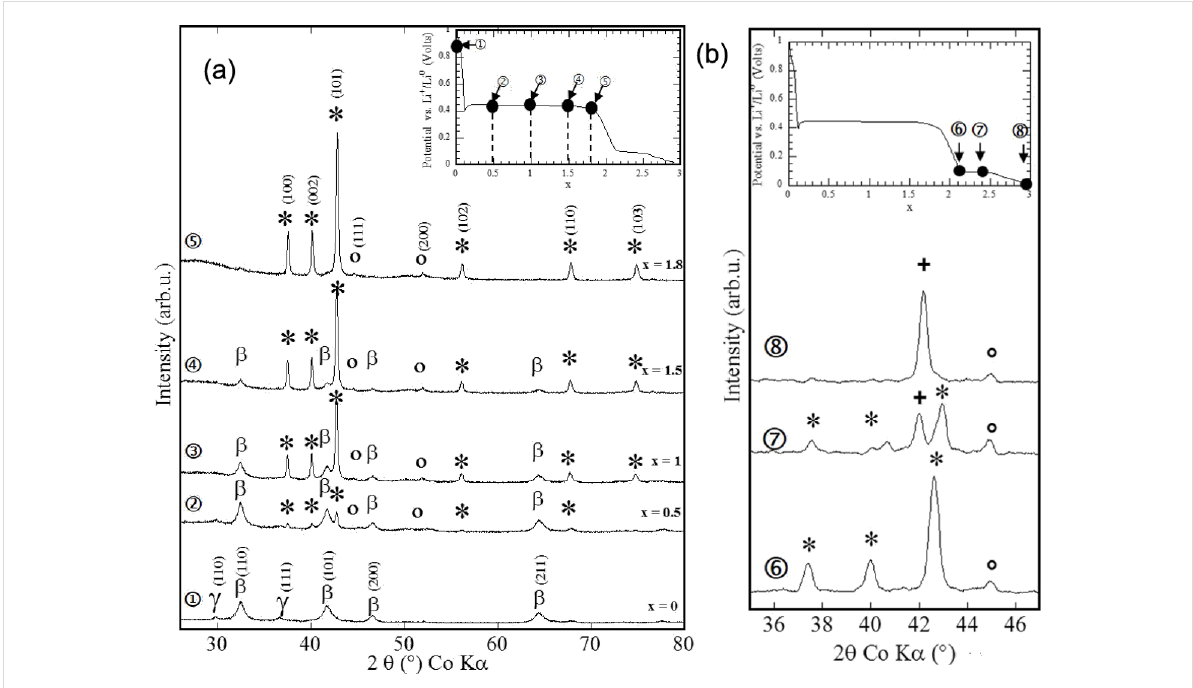
Figure 4: Potential profile and XRD patterns of MgH 2 electrode at different stages of the conversion reaction. (a) Inset: Evolution of the potential (V) as a function of x (mole fraction of Li) for a MgH 2 electrode cycled between 3 and 0.005 V at a rate of one equivalent of lithium in 100 h. The recorded XRD patterns are associated with the various stages of the discharge, denoted by the numbers (1), (2), (3), (4) and (5) in panel and correspond to x = 0 (starting electrode material), x = 0.5, 1, 1.5 and 1.8, respectively. The X-ray peaks marked by an asterisk, β , γ and circle correspond to Mg, β -MgH 2 , γ -MgH 2 and LiH, respectively. b) Inset: Evolution of the potential (V) as a function of x (mole fraction of Li) for a MgH 2 electrode cycled between 3 and 0.005 V at a rate of one equivalent of lithium in 100 h. The XRD patterns (6), (7), and (8) corresponding to x = 2.1, 2.35 and 2.9. The Bragg peaks marked by an asterisk and plus sign correspond to Mg (hcp) and Li (bcc) solid solutions, respectively. Adapted from [5] (copyright 2008 Nature Publishing Group) and [11].